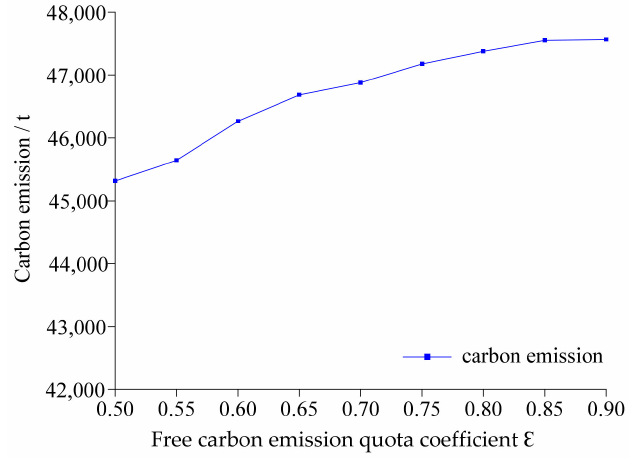
Figure 12. The carbon emissions of IPGES under different free carbon emission quota